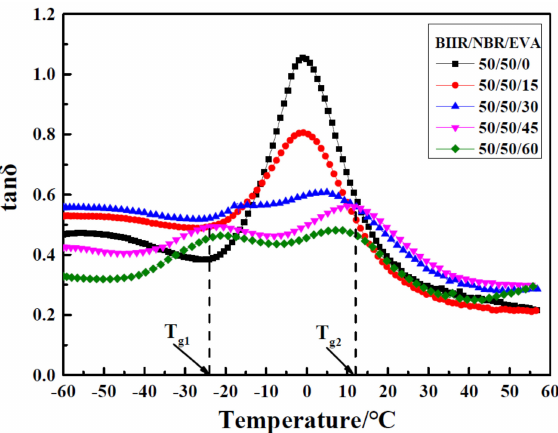
Figure 26. Damping loss factor versus temperature for NBR/BIIR/EVA with various blend ratios.